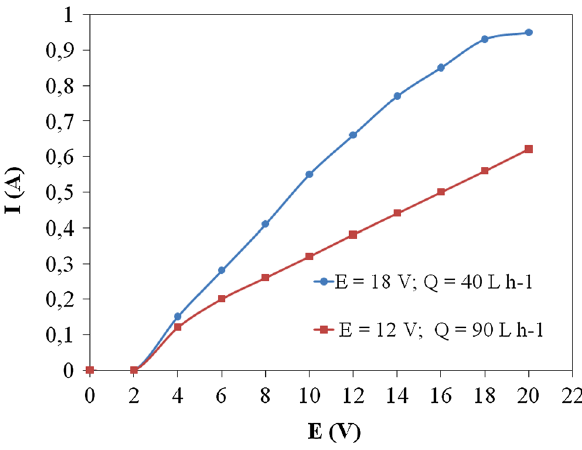
Fig. 10 Polarization curves, I = f (